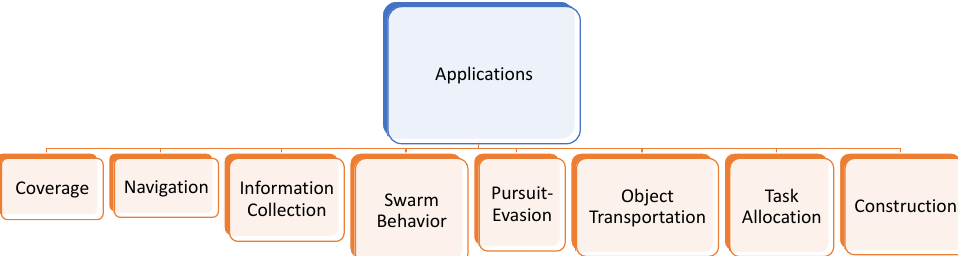
Figure 5. Multi-robot system applications that primarily use MADRL